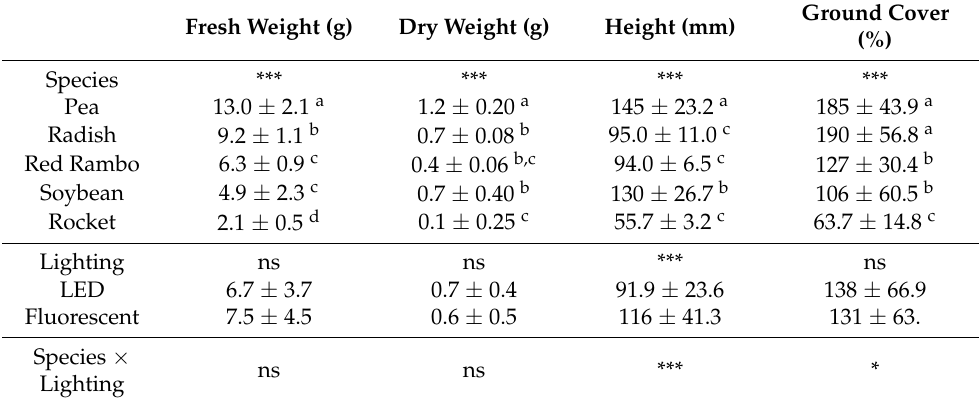
Table 1. Growth parameters for species (green pea, radish, Red Rambo, soybean, and rocket micro- greens) and lighting (LED and fluorescence) at 10